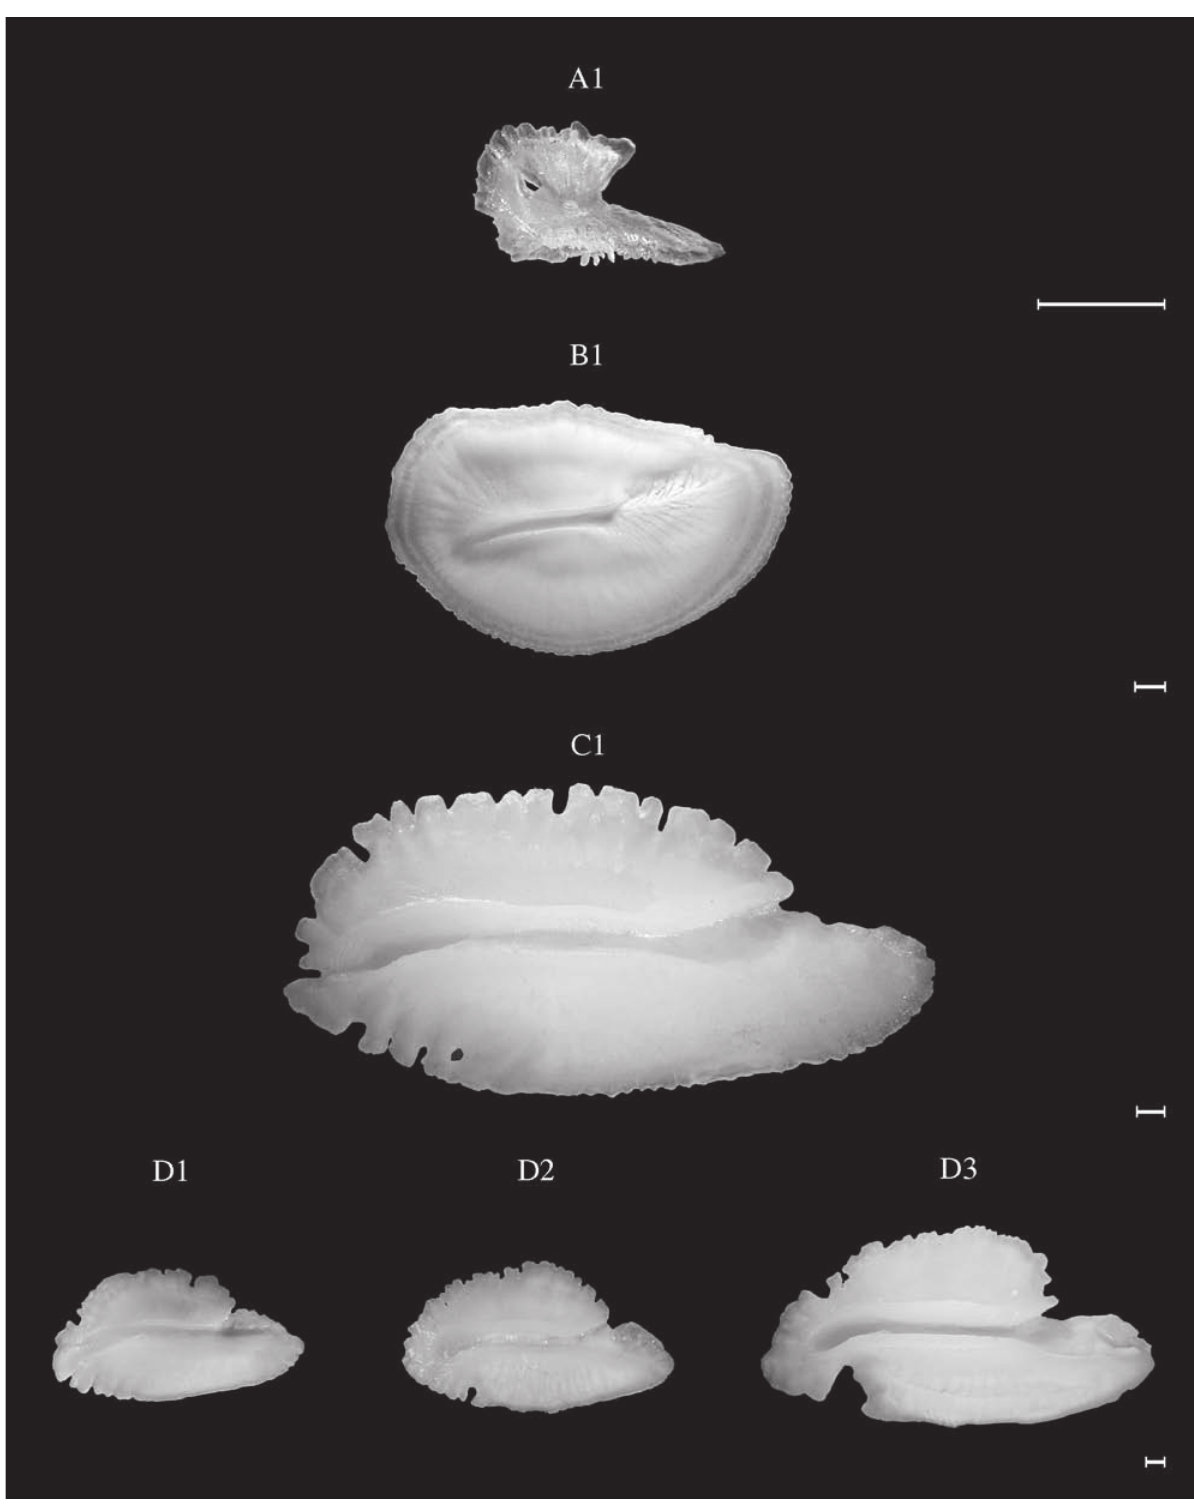
Fig. 86. – Xiphias gladius (WM). TL: A1, no available. Schedophilus medusophagus (WM) . TL: B1, 50.0 cm. Schedophilus ovalis (CEA). TL: C1, 84.3 cm. Schedophilus velaini (CEA) . TL: D1, 58.8 cm; D2, 67.0 cm; D3, 88.6 cm. Scale bar = 1